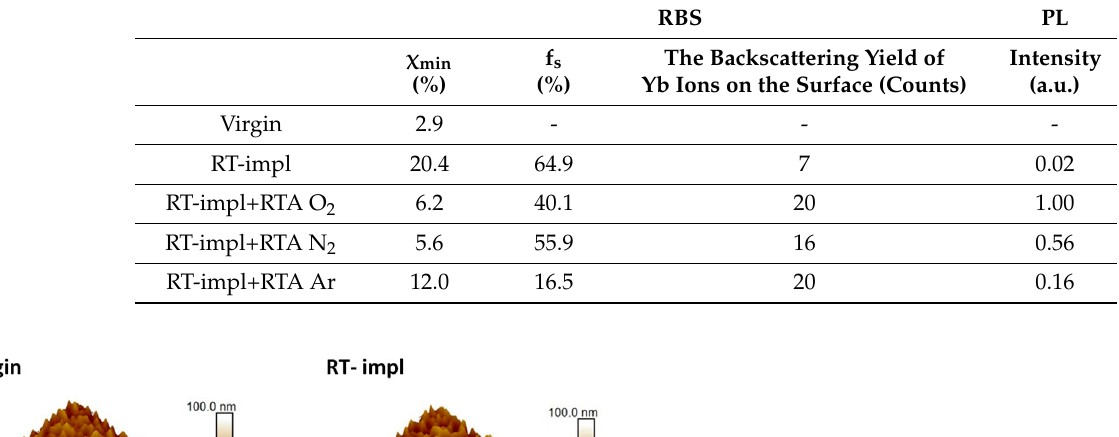
ions at the fluence of 5x10 14 /cm 2 and RTA-annealed.